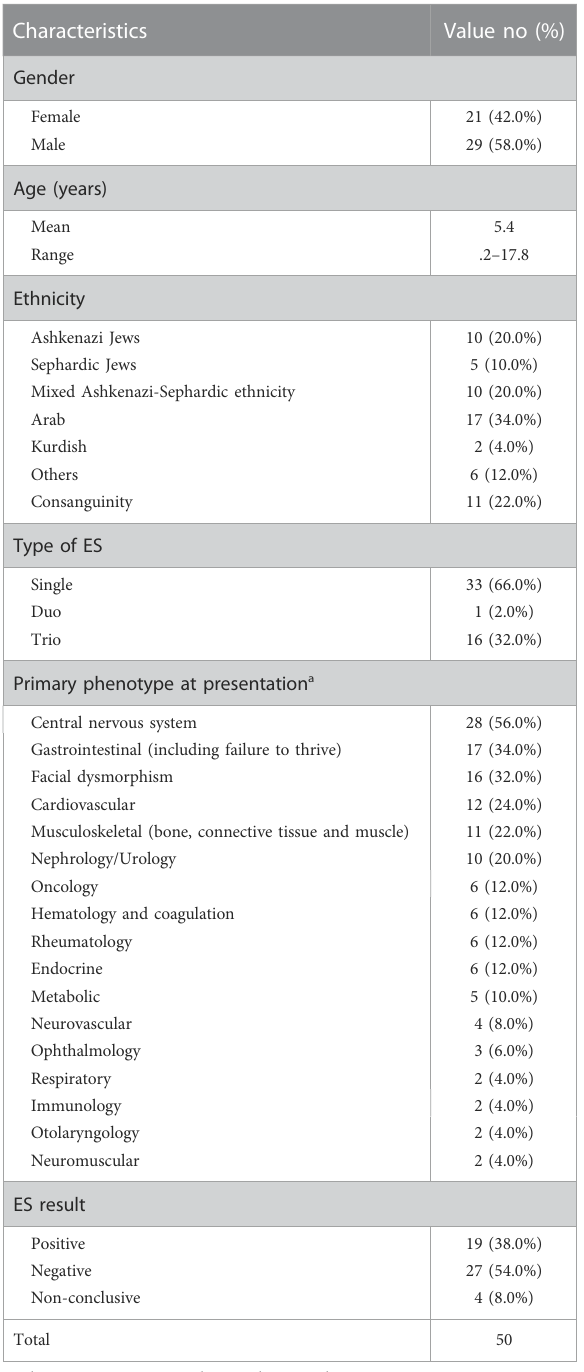
TABLE 2 Demographic and phenotypic characteristics of the fi fty probands evaluated by exome sequencing (ES).